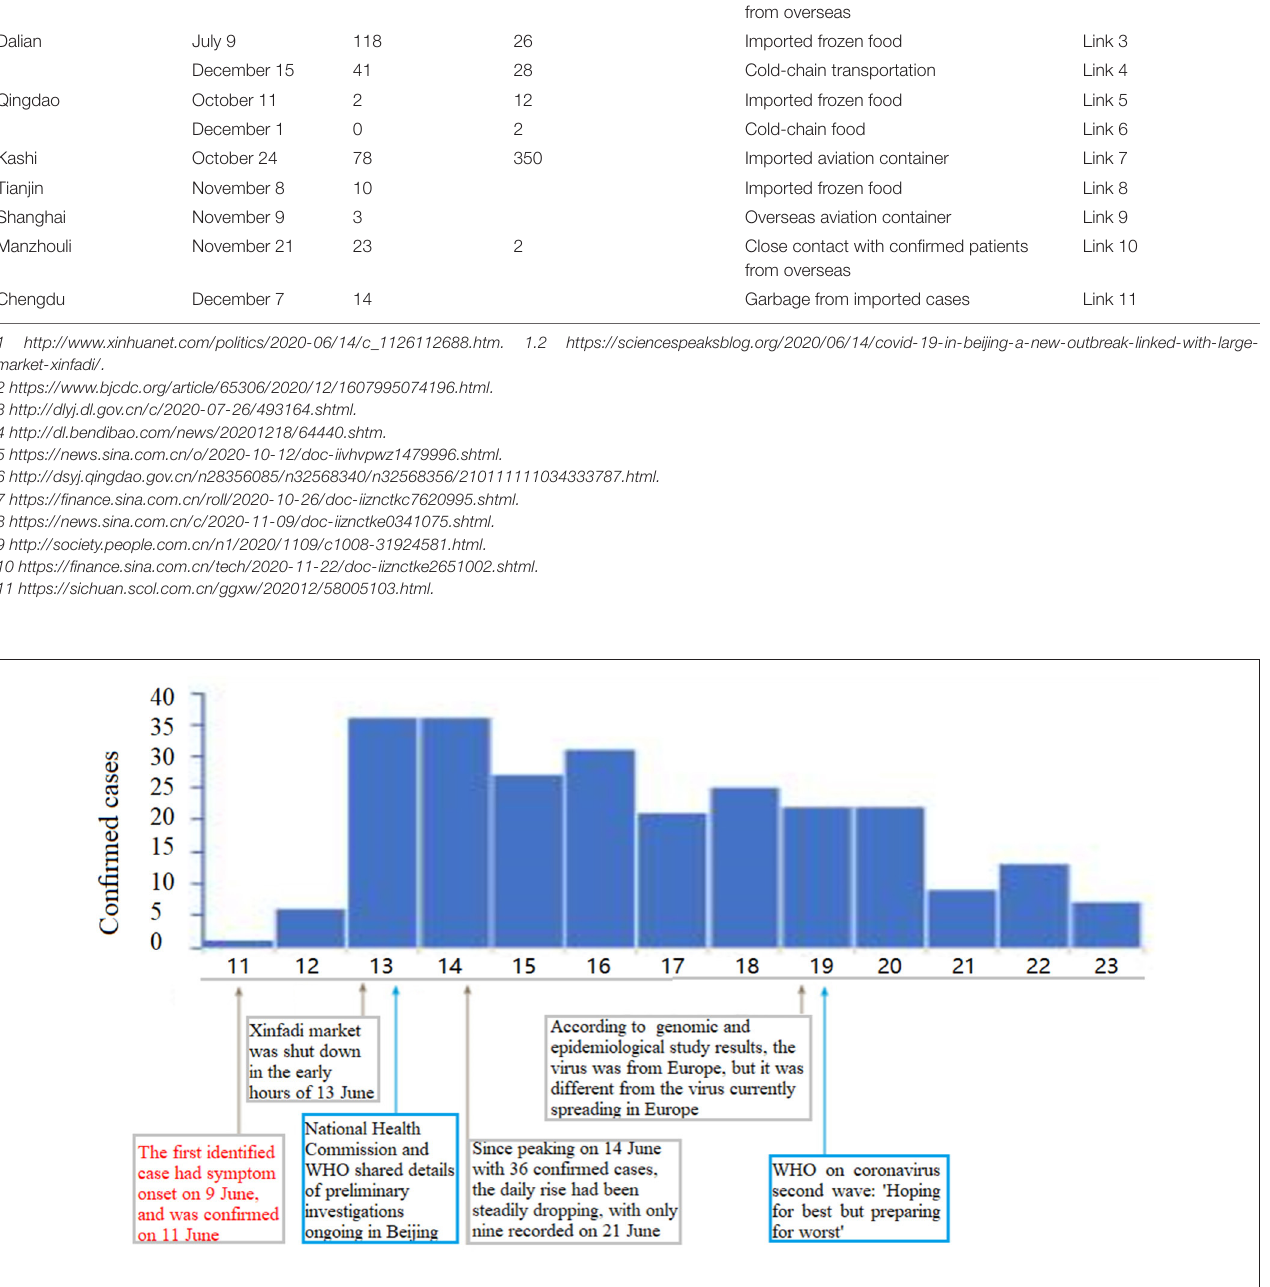
FIGURE 3 | Graph’s x-axis (dates from June 11 to 23, 2020) is used as a timeline of key events and dynamic profile during COVID-19 outbreak. Profiles of confirmed cases are shown in graph’s y-axis. First case in Beijing’s fresh outbreak was recorded on June 11. Inset shows that daily rise had been steadily dropping, with only nine recorded on Jun 21, since peaking on June 14 with 36 confirmed cases.